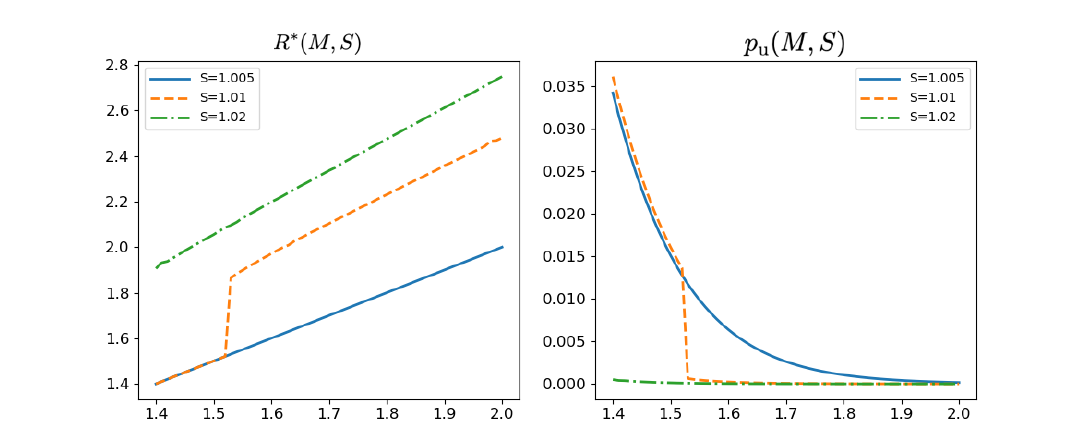
Figure 2. Plots of system behavior as a function of M for fixed lognormal distribution parameters of µ = 0.033 and σ = 0.2 and various values of S . ( Left ) Agent’s optimal collateral ratio R ∗ ( M , S ) with respect to M . Note that when S is low, the agent’s optimal action is to set R = M , but that larger values of S render other, less-risky collateral ratios optimal. ( Right ) Probability of undercollateralization p u ( M , S ) with respect to M . Several features are of note here: first, when S = 1.02, the probability of undercollateralization is extremely low, despite the fact that only a 2% penalty is assessed the agent in the event of a margin call. Second, when S ≤ 1.01, the probability of undercollateralization ( p u ) is sharply dependent on the value of M , can be as high in these simulations as 3.5%, and for S = 1.01, p u is discontinuous around M = 1.53. That is, the probability of undercollateralization is extremely sensitive to the operator’s selection of M